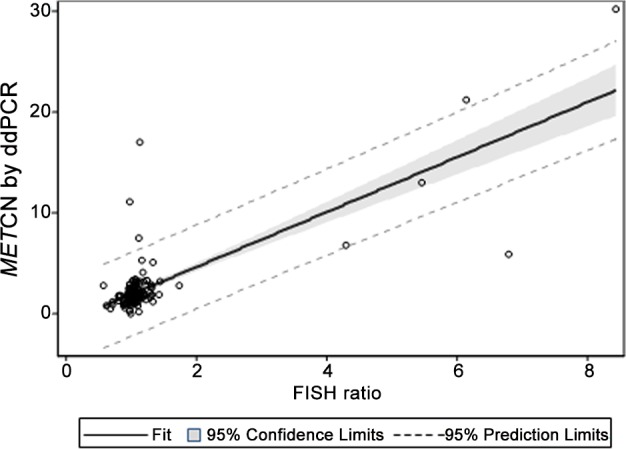
Distribution of MET CN measured by ddPCR in MET amplification and non-amplification groups by FISH.P-value was based on t-test assuming difference variances of each group. Each data for MET CN using ddPCR represents two or three merged technical replicate wells with no template control (NTC) as a negative control.